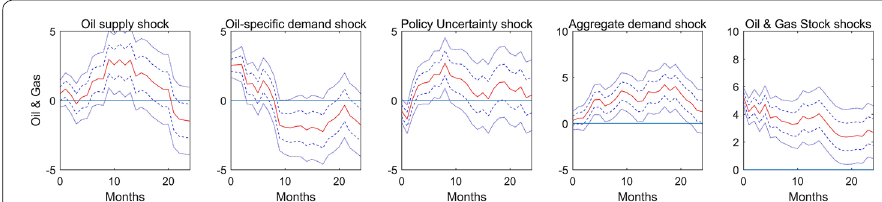
Fig. 3 Responses of oil and gas industry returns to one and two standard deviation structural shocks: